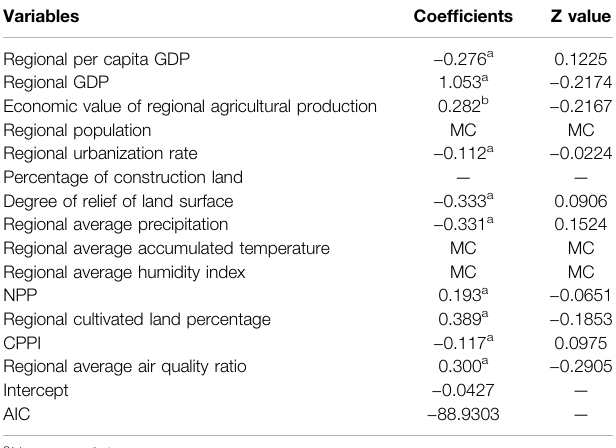
TABLE 3 | Results of the